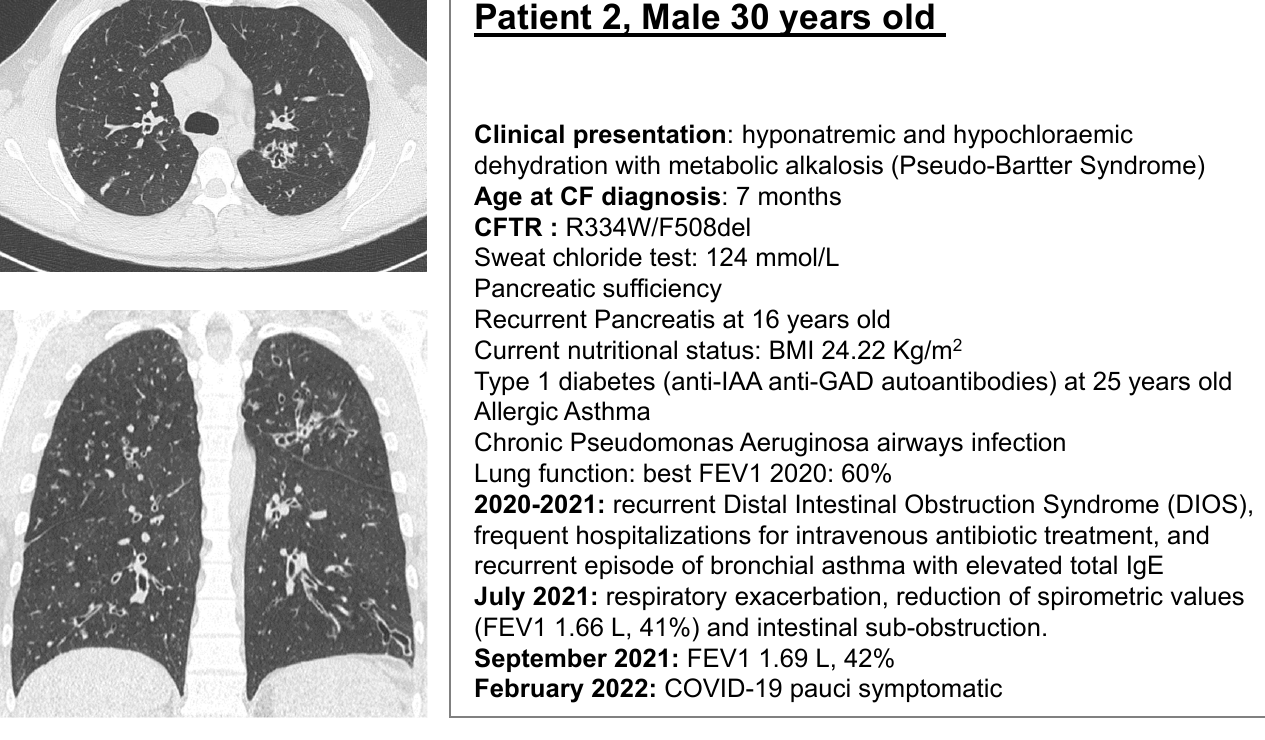
Figure 1. CT pulmonary scan and main clinical features of Patient 1 (E193K/F508del), and Pa- tient 2 (R334W/F508del) with cystic fibrosis. The CT scan images show diffuse bronchiectasis in both subjects, with the radiological damage and deterioration rate across the years more marked in Patient 1 despite apparently milder clinical features and a RF mutation combined with F508del (E193K/F508del). Patient 2 (R334W/F508del) has worse lung function spirometry values also influ- enced by comorbidities and a more evident gastrointestinal